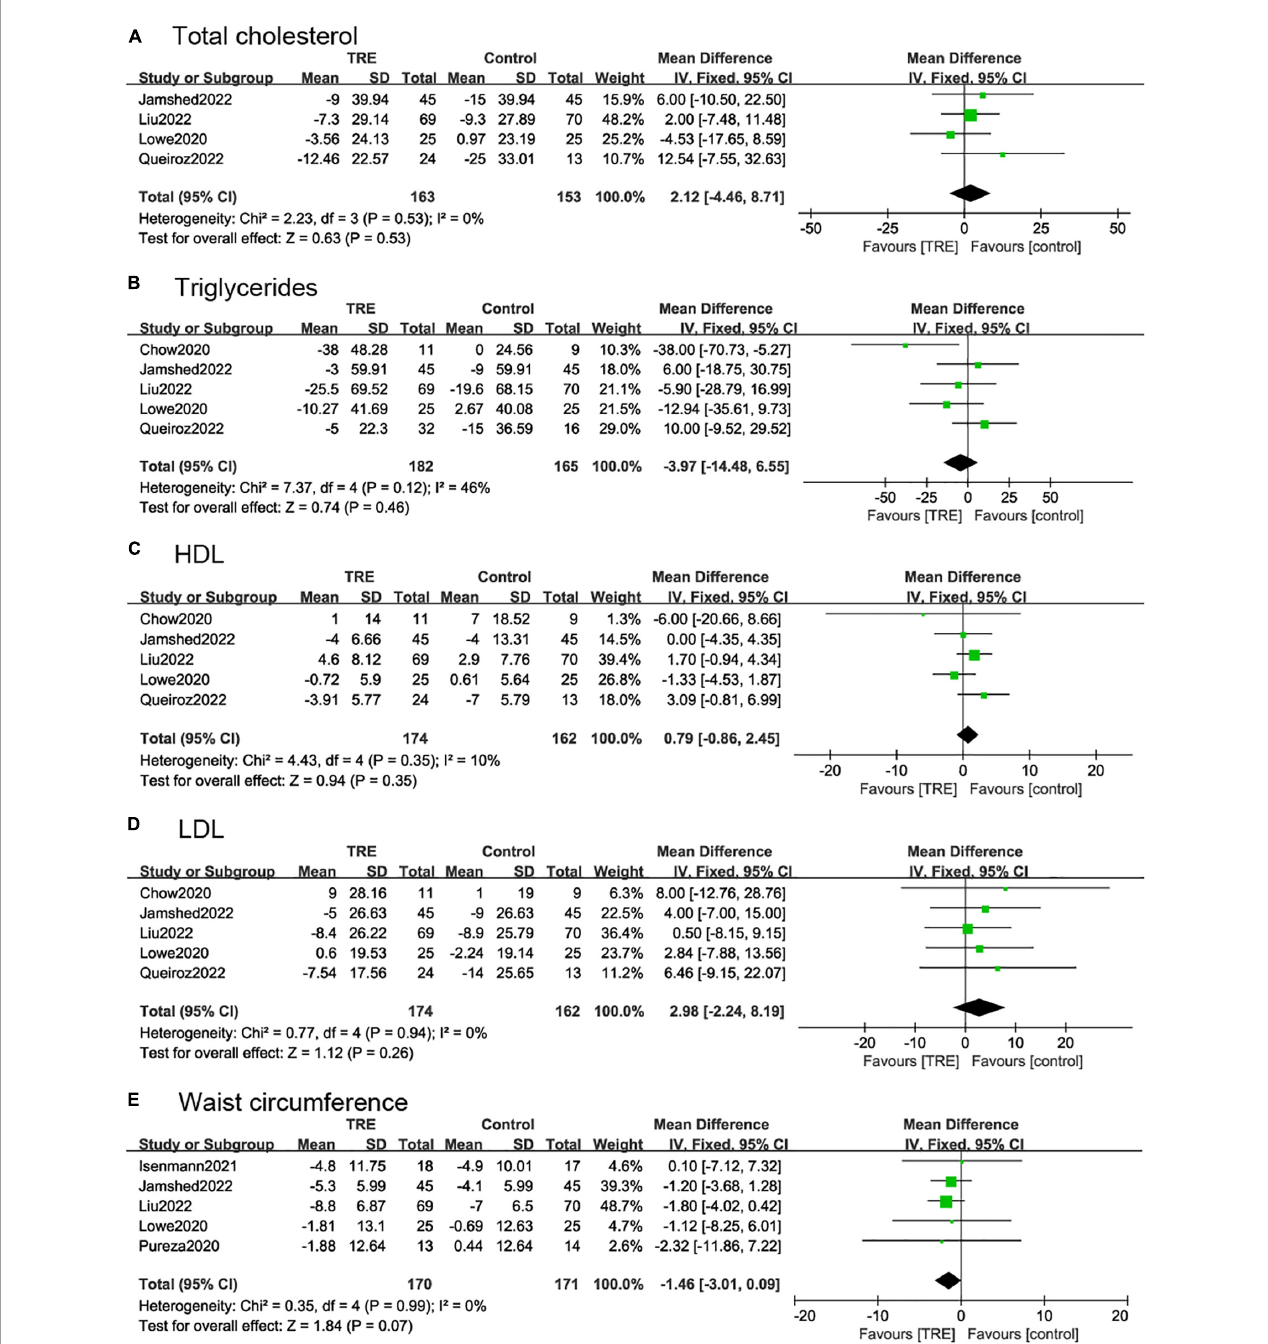
FIGURE6 Forest plots of comparisons between TRE and the control groups in (A) total cholesterol; (B) triglycerides; (C) high-density lipoprotein (HDL); (D) low-density lipoprotein (LDL); and (E) waist